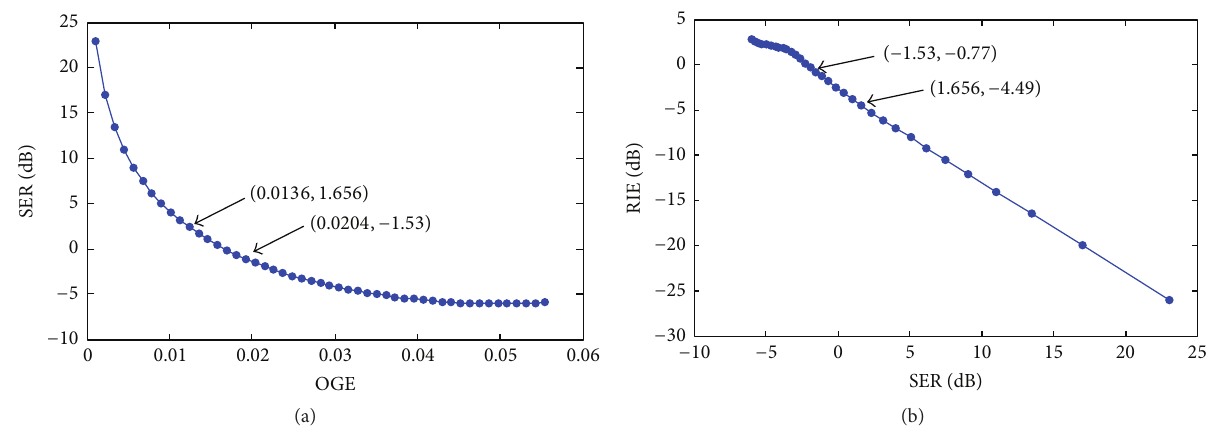
Figure 3: Off-grid effects on imaging quality. (a) SER versus OGE. (b) RIE versus